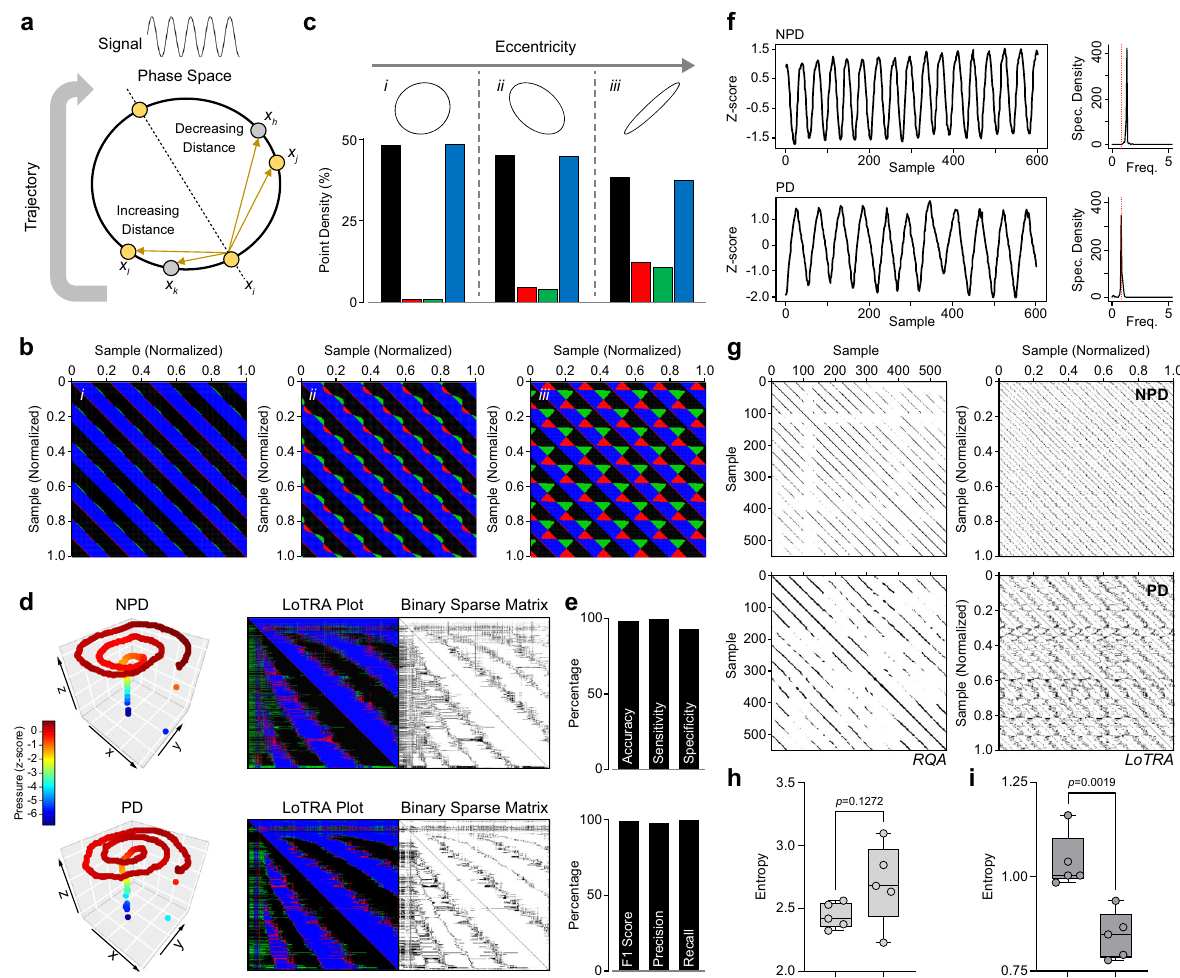
Fig. 1 LoTRA: Parkinson ’ s gait and handwriting. a Top, 1-dimensional dynamic signal; sine wave. Bottom, 2-dimensional phase-space reconstruction of the sine wave signal where it is easy to distinguish between x i − x l and x i − x j based on local neighborhoods. b LoTRA plots of three different phase-space reconstructions (inset in c ). c Colors represent quartiles of the 8-bit binary code associated with topological features used to create a binary matrix to parse the signal ’ s component parts (see “ Methods ” ). d Multi-dimensional time-series data for digital handwriting samples from the Dynamic Archimedean Spiral Test for non-PD (NPD) and PD (left), their associated LoTRA plots (center), and their high-curvature binary sparse matrices (right) with which recurrence statistics are extracted. e Top; diagnostic-based performance metrics: accuracy = 98.6%, sensitivity = 100%, and speci fi city = 93.3%. Bottom; classi fi cation model performance metrics: F1 score = 99%, precision = 98.2%, and recall = 100%. f NPD and PD gait data from a single wearable sensor (left). Shifted spectral peak in PD indicting slower gait cycling (right). g Additional information related to underlying disturbances in gait-cycle complexity captured by recurrence plots (left) and LoTRA plots (right) for each trace shown. h RQA summary data ( t (8) = 1.702, p = 0.127). i LoTRA summary data ( t (8) = − 4.542, p = 0.002). All box plots represent median and upper and lower